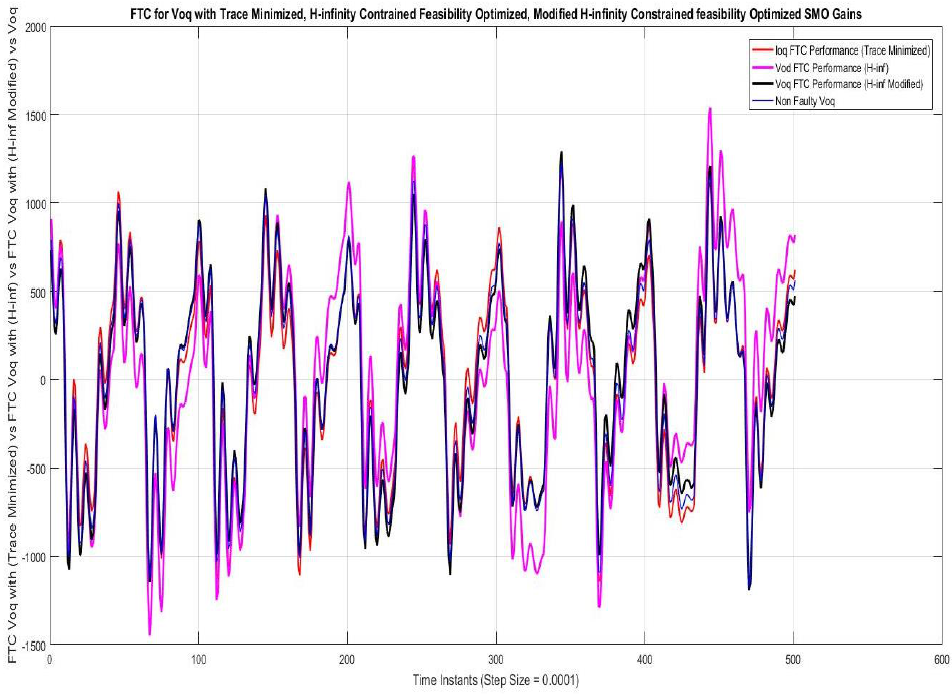
Figure 14. FTC performance for d-component of output